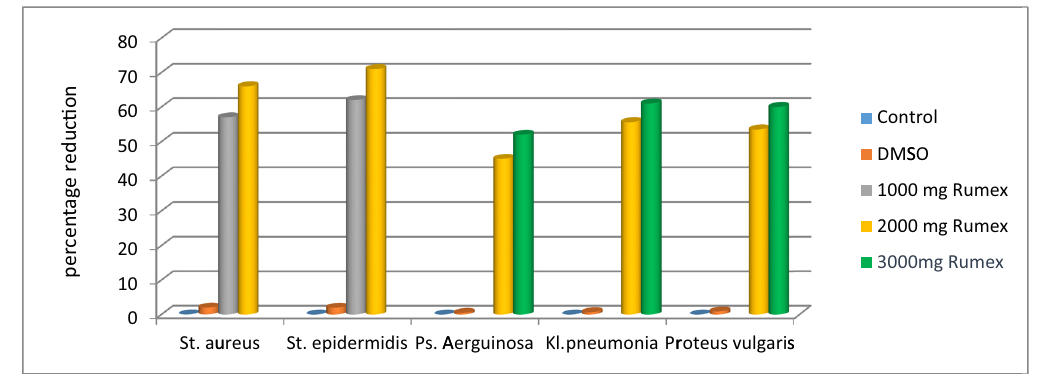
Figure 2: E ff ect of di ff erent concentrations of methanol extract of R. vesicar ius L. on bio fi lm formation of di ff erent isolates.